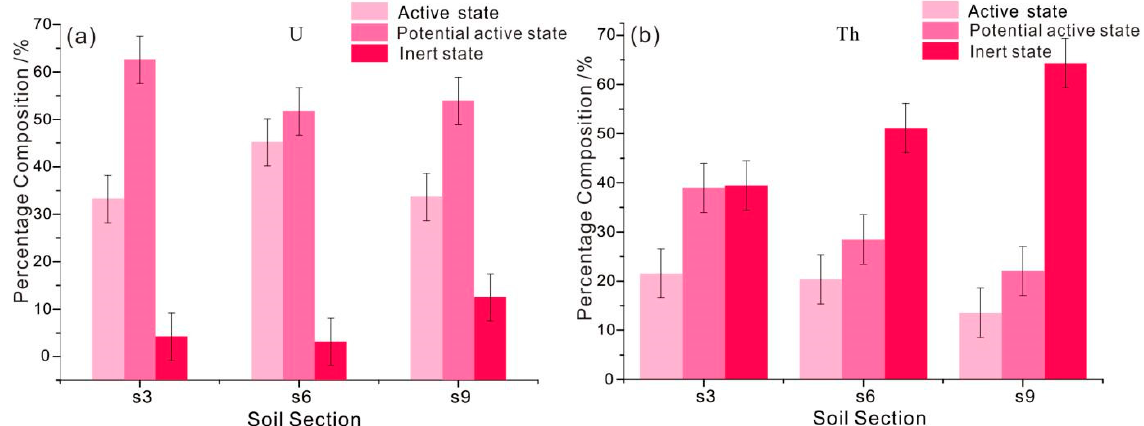
Figure 7. ( a )Ecological activities of U and ( b )Th elements in different soil profiles. Figure 7. ( a ) Ecological activities of U and ( b )Th elements in different soil